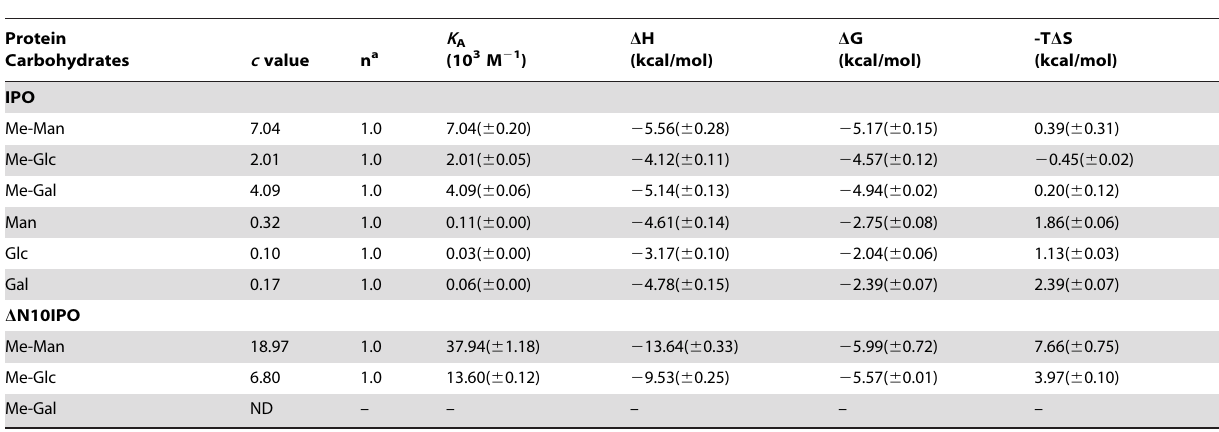
Table 2. Thermodynamics values of IPO and D N10IPO titrated with various carbohydrates*.